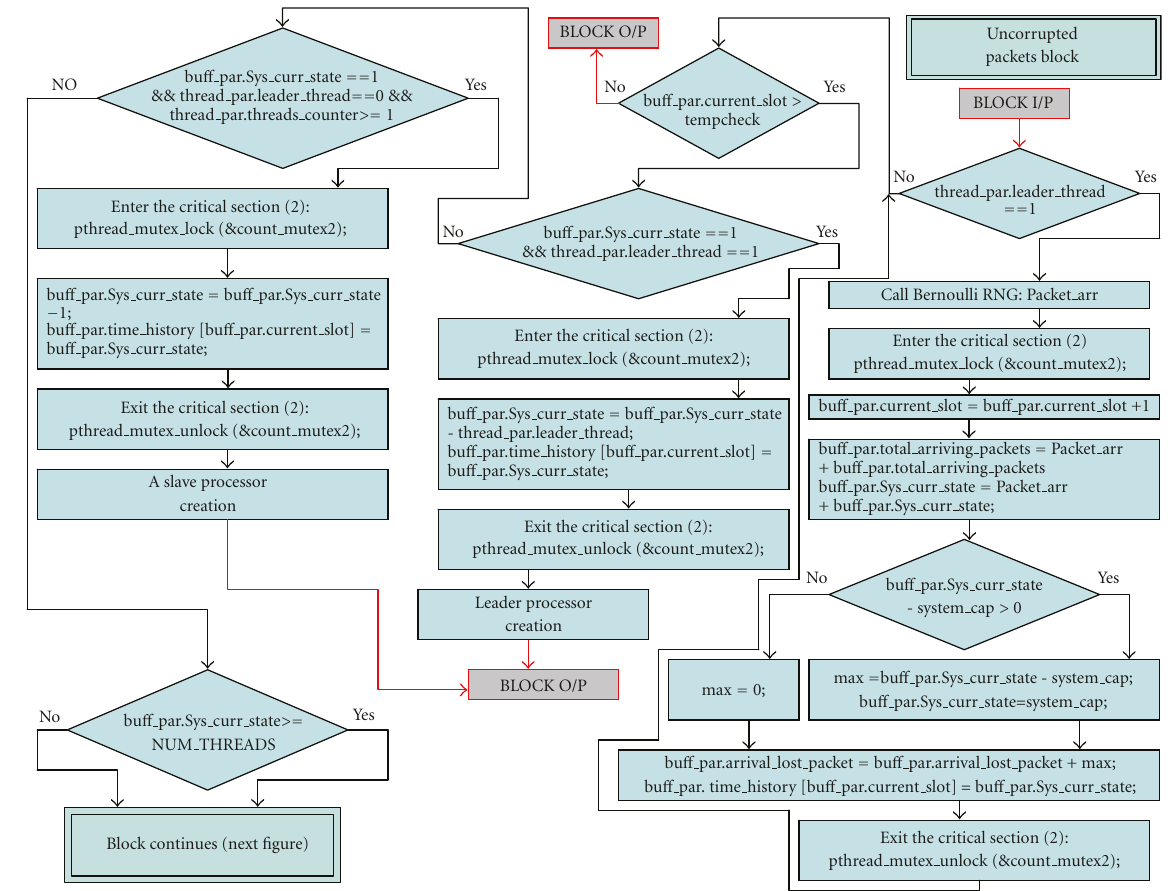
Figure 13: Major simulation steps for uncorrupted packets block shown in Figure